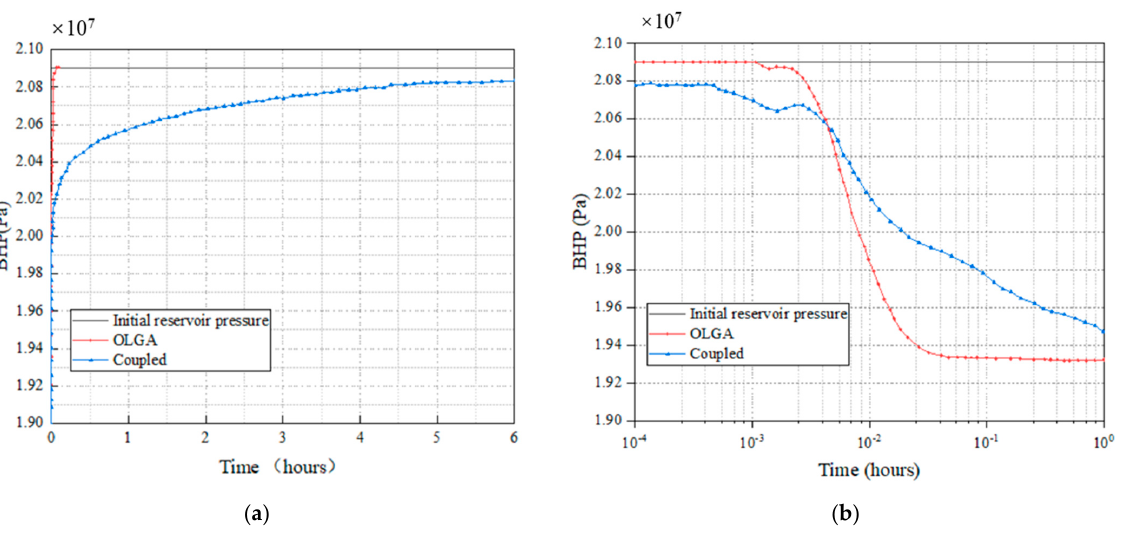
Figure 8. Comparisons of BHP versus time ( a ) build-up period after shut-in and ( b ) start-up period from coupled simulator and OLGA. This figure was modified from Figures 9 and 14 in ref [4].